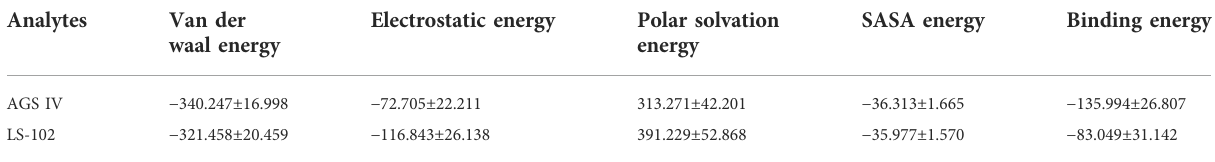
TABLE 3 Calculated values that contributed to binding-free energy from Poisson Boltzmann surface area (MM/PBSA). Analytes